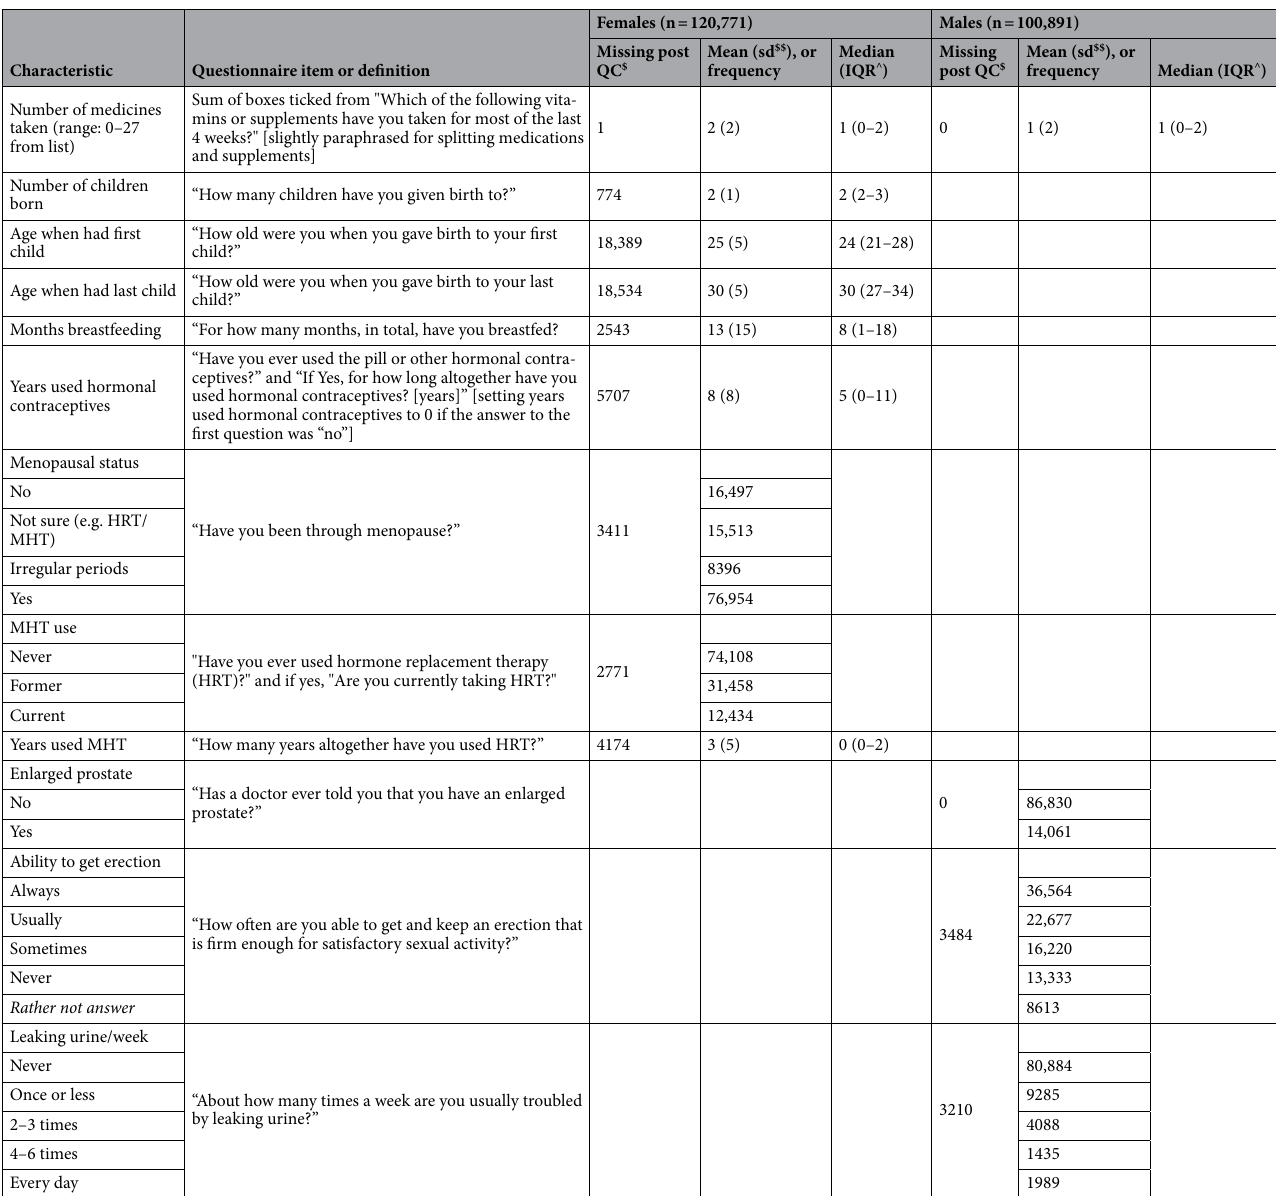
Table 1. Characteristics of the 45 and Up Study cohort at baseline, including age and all cancer risk variables used in the factor analysis. $ Missing post QC Missing values after exclusion of outliers (see Supplementary Table S1). $$ sd standard deviation. ^ IQR interquartile range Associations between combined factors and cancer incidence. We tested the association between each combined factor and cancer incidence (separately for all cancers, and for lung, bowel, breast, prostate can- cers, and melanoma) using logistic regression. In each logistic regression analysis, cases were participants newly diagnosed with cancer after recruitment (separately for all cancers, lung, bowel, breast, and prostate cancer, and melanoma), while all other participants were included as non-cases. We applied the function “glm” in R with